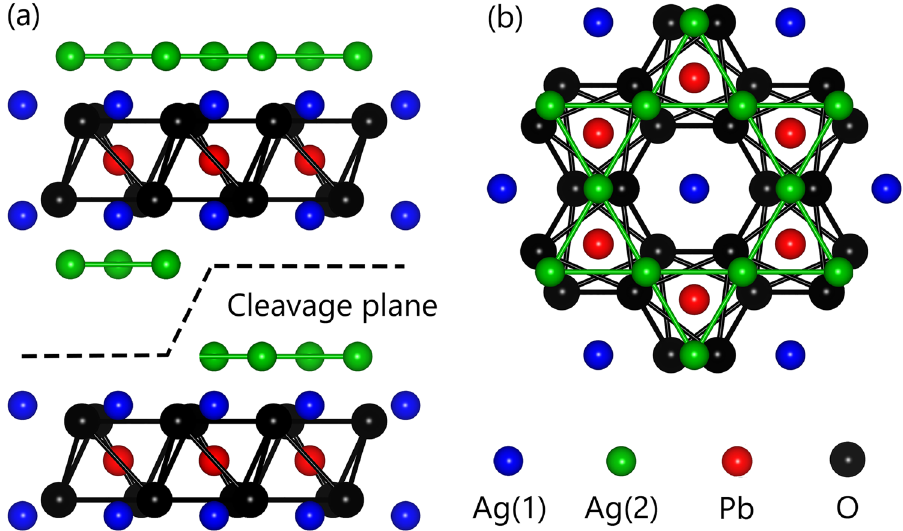
Figure 1. ( a ) Side view and ( b ) top view of the crystal structure of Ag 5 Pb 2 O 6 . Green, blue, red, and black spheres represent Ag(1), Ag(2), Pb, and O ions, respectively. Two possible cleavage planes with Ag(1) and Ag(2) terminations are shown as a dashed